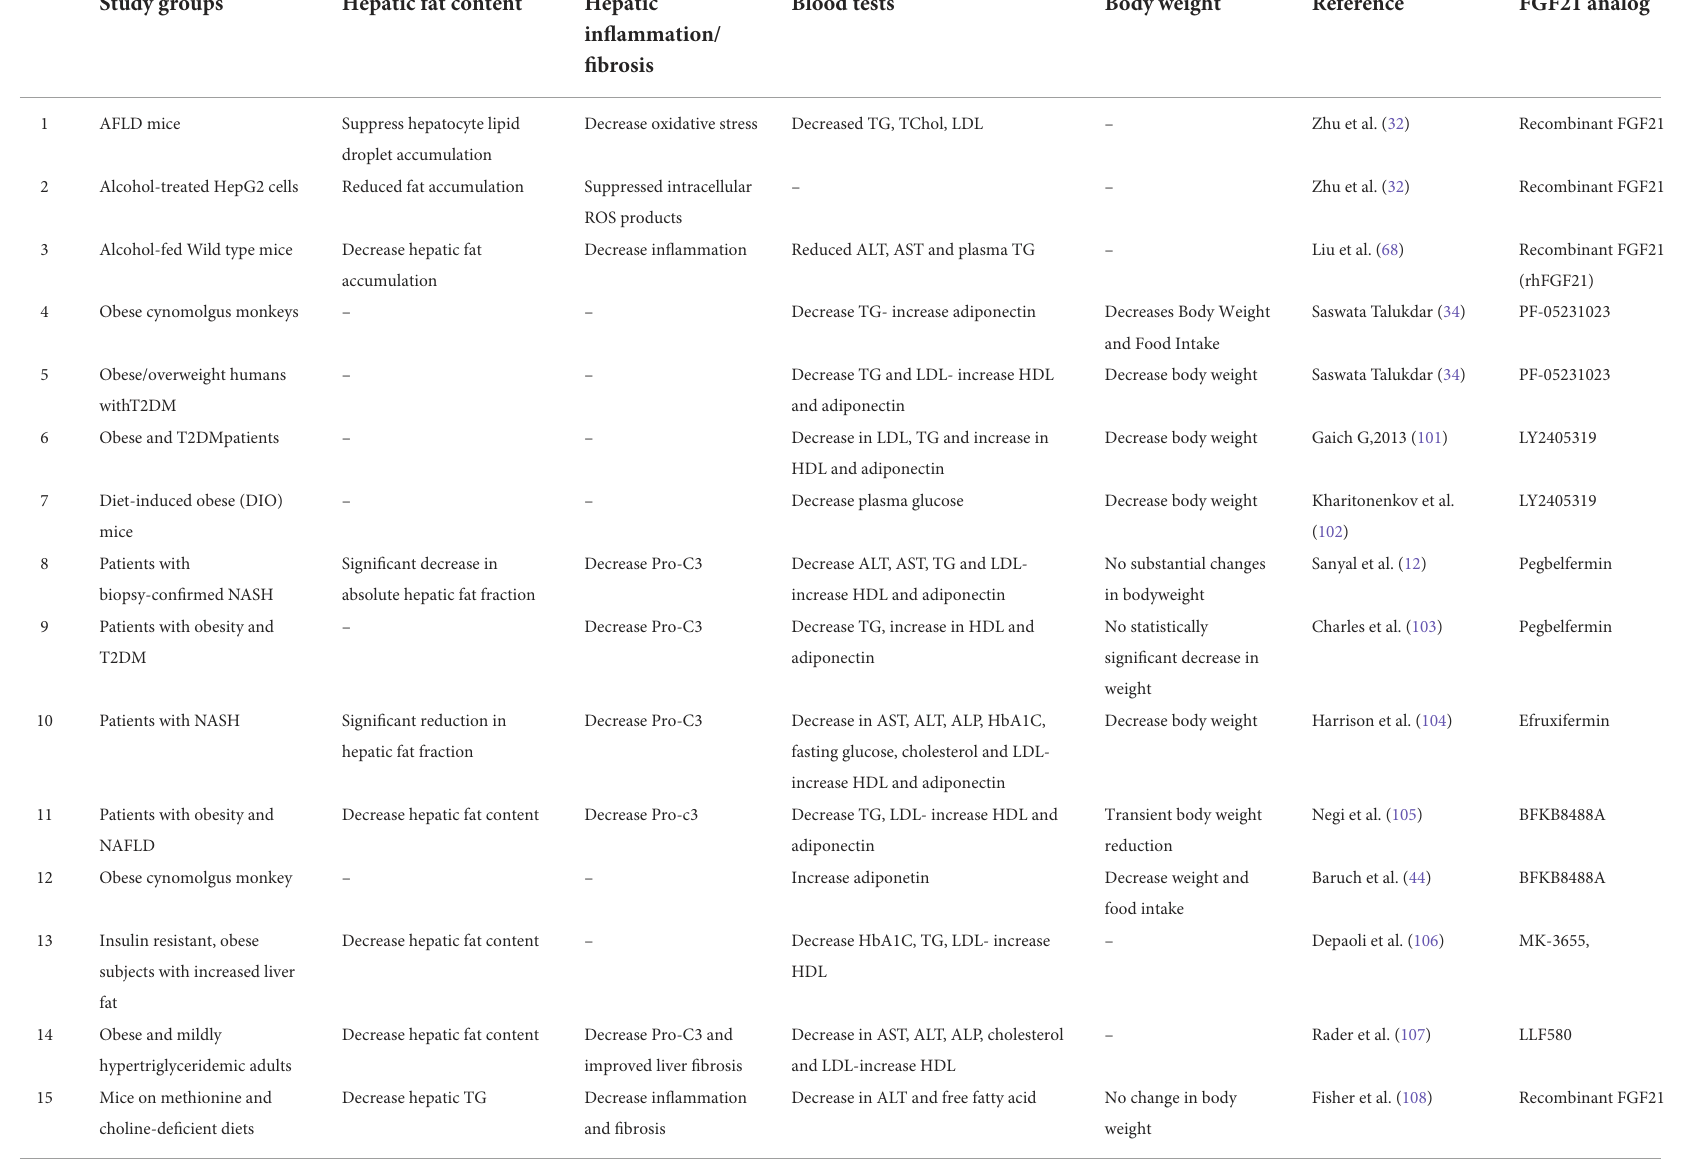
TABLE 2 The summarized table of the FGF21 analogs and the effect of the analogs on the body. Study groups Hepatic fat content Hepatic